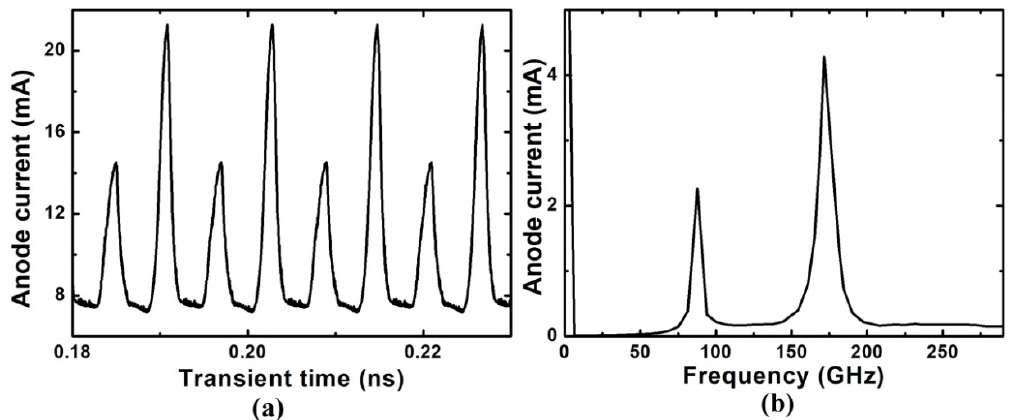
Figure 11. ( a ) The current oscillation wave and ( b ) the frequency spectrum diagram of the grooved-anode diode, where L a = 1.0 µm and L b = 2.0 µm.